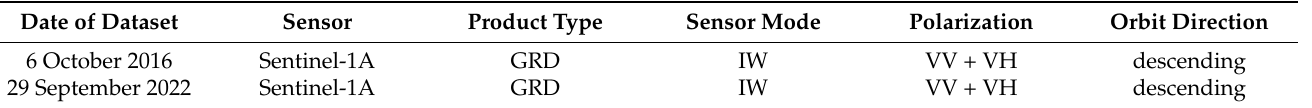
Table 1. SAR Data